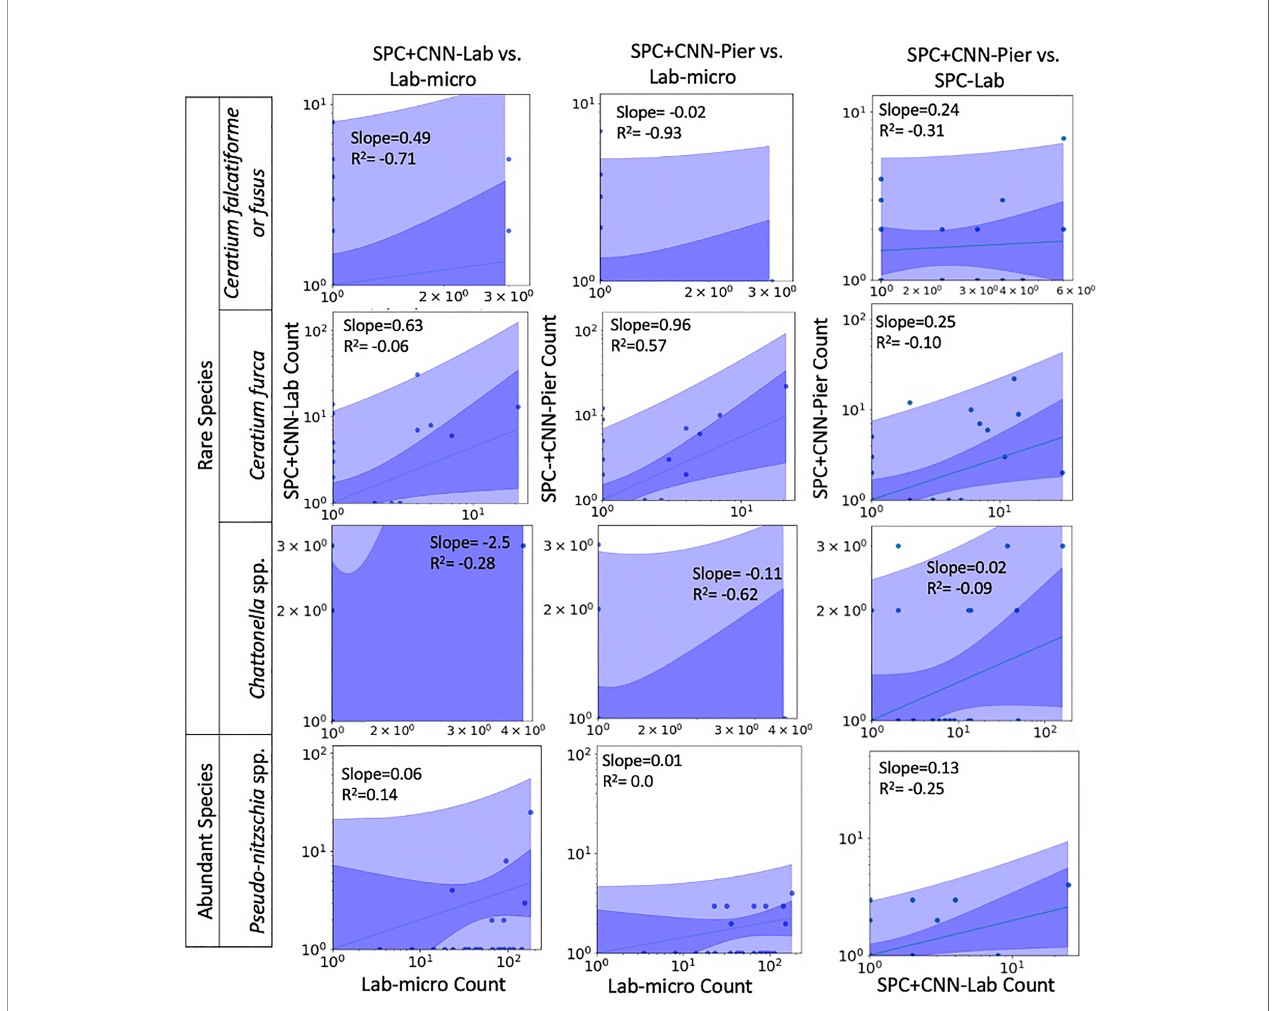
FIGURE 7 | Relationships between counts of Lab-micro and SPC+CNN methods (less abundant species). Columns highlight pairs of counting methods, rows demarcate species. The solid line indicates a linear regression model that is coupled with multiple shaded areas indicating the 95% prediction (dark shade) and con fi dence interval (light shade). The slope and R 2 of the model fi t are